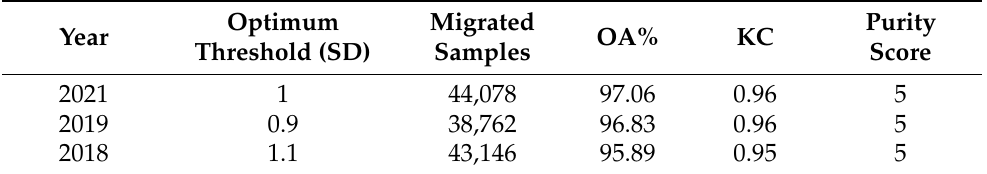
Table 4. Summary of the results in migrating reference samples to each target year using the proposed